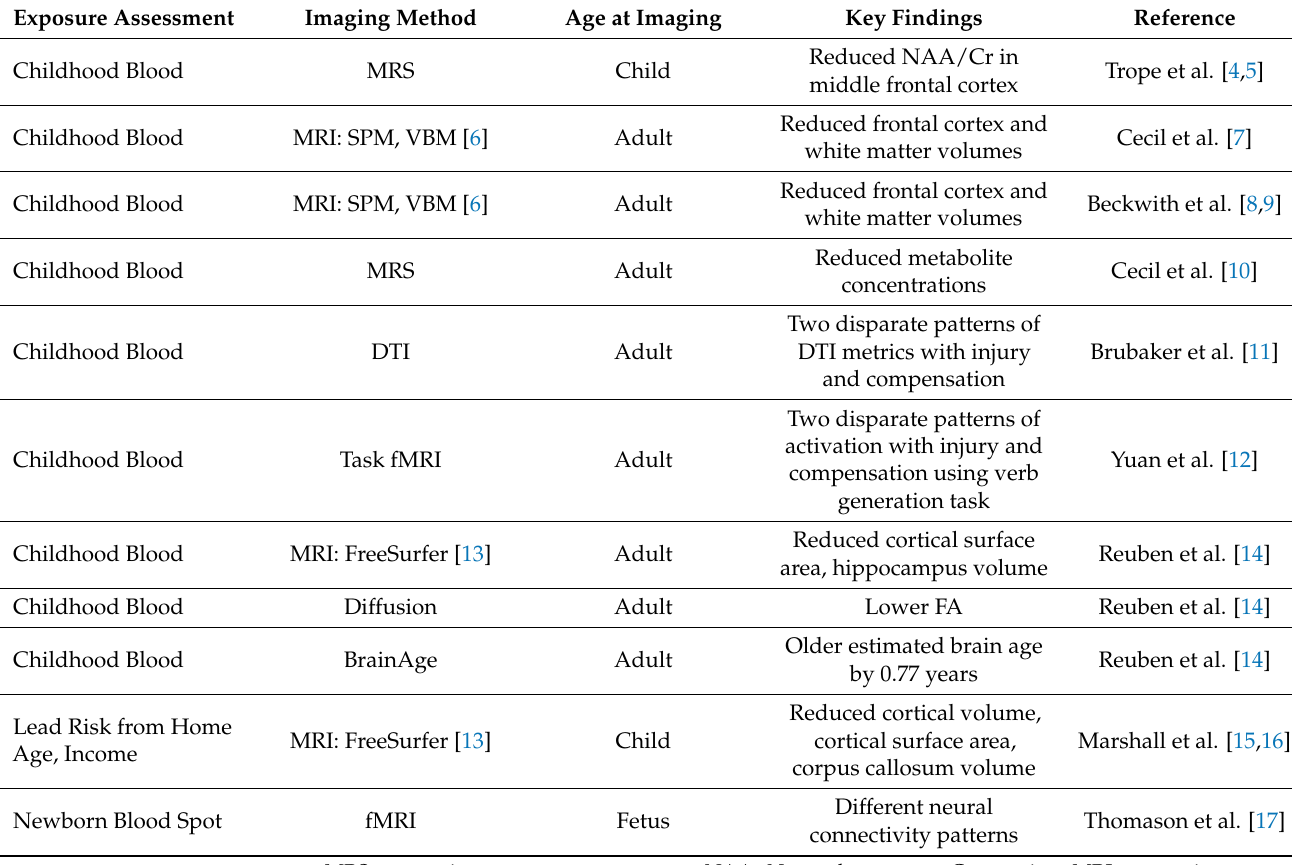
Table 1. Summary of neuroimaging findings associated with increased lead